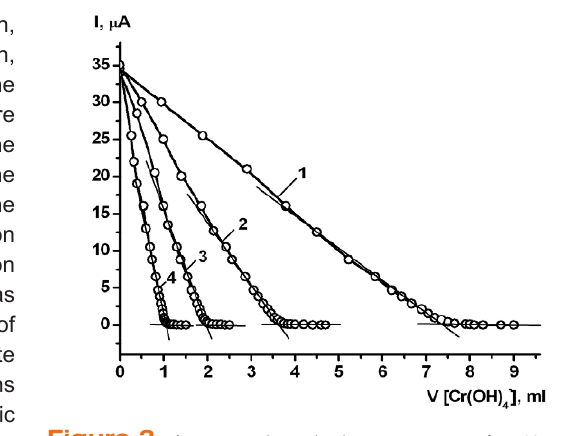
Figure 3. Amperometric titration curves of 10 mL 7.17×10 -4 М ferrate(VI) solution using different [Cr(OH) 4- ]: 1 – 9.85×10 -4 М ; 2 – 2.01×10 -3 М ; 3 – 3.73×10 -3 М